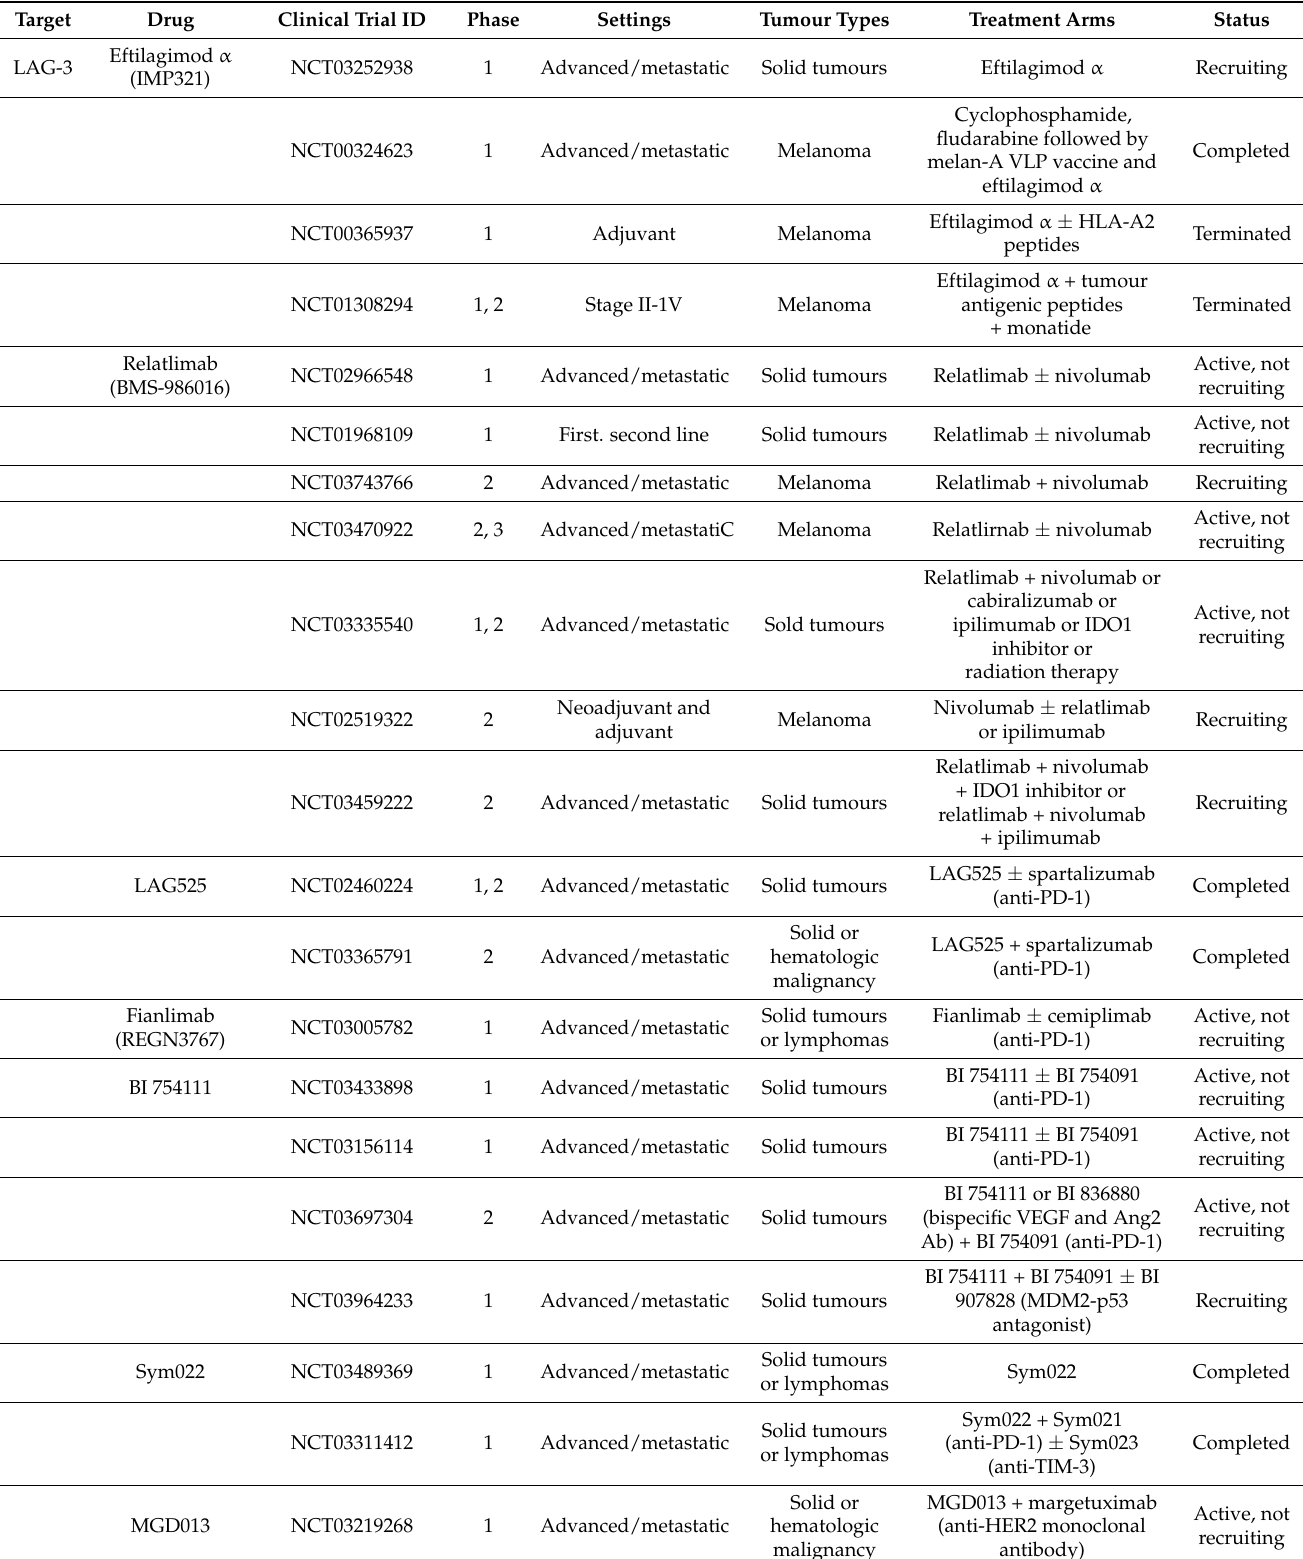
Table 1. Current clinical trials of novel and combinatory checkpoint inhibitor drugs for solid